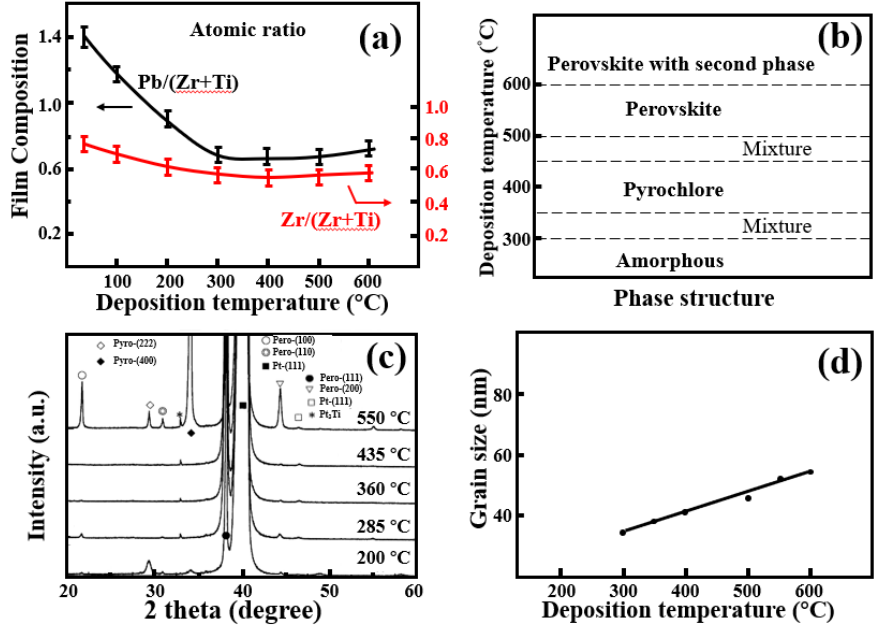
Figure 5. ( a ) Variation of Pb content and Zr/Ti ratio as a function of deposition temperature. Re-